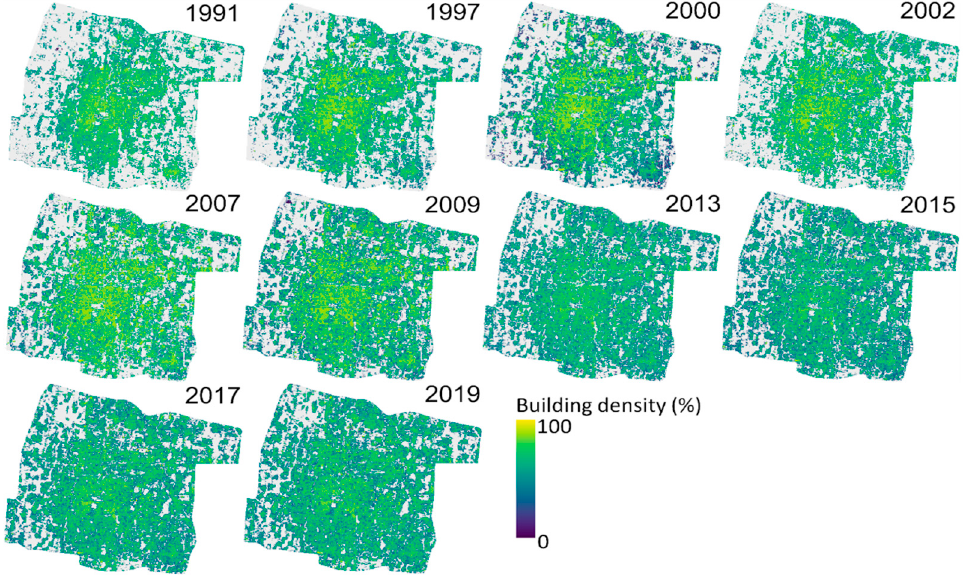
Figure 7. Building density maps estimated by support vector regression (SVR). Overestimates are shown in the images of 1991–2009 derived from Landsat 5/7.